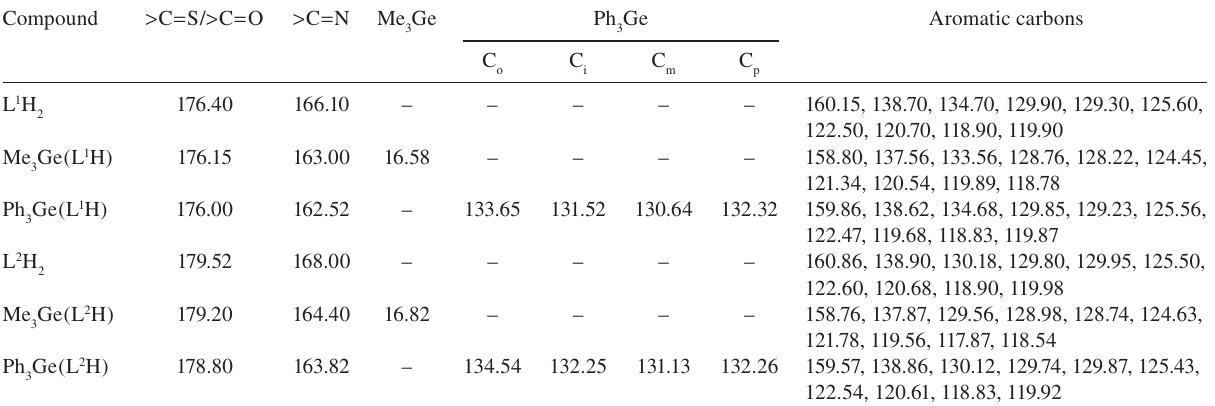
and L 2 H ) and their triorganogermanium(IV) complexes. 2 2